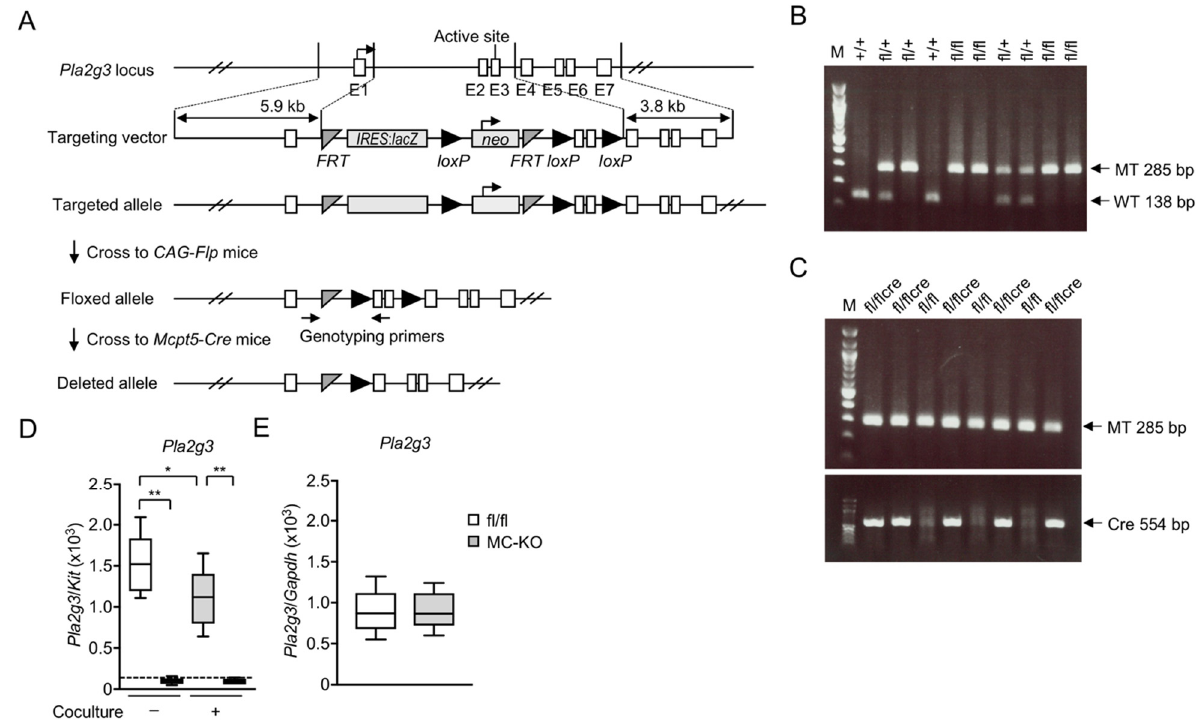
Figure 1. Generation of MC-specific Pla2g3 -deficient mice. ( A ) A schematic representation of the mouse Pla2g3 locus, the targeting vector from KOMP, the targeted Pla2g3 allele with a lacZ / neo cassette, the floxed Pla2g3 allele after removal of the lacZ cassette by flippase, and the Pla2g3 -deleted allele after removal of the neo cassette by Cre recombinase. The floxed mice were bred with Mcpt5 - Cre mice, and sequences between the two loxP sites were removed from the offspring’s genome in an MC-specific manner. Positions of primers for genotyping are marked with arrows. E1–7 (open boxes), Pla2g3 exons; FRT (gray isosceles triangles), sites for flippase; IRES , internal ribosome entry site; lacZ (gray box), gene encoding β -galactosidase; neo (gray box), neomycin phosphotransferase; loxP sites (black right triangles), target sites for Cre recombinase. Adapted from www.KOMP.org. ( B , C ) A representative genotyping PCR on agarose gels. The amplified PCR products specific for the floxed allele (MT, 285 bp), WT Pla2g3 allele (WT, 138 bp), and Mcpt5 - Cre allele (Cre, 554 bp) are indicated. ( D , E ) Quantitative RT-PCR of Pla2g3 in BMMCs with (+) or without ( − ) coculture with 3T3 fibroblasts (n = 6) ( D ) and splenocytes (n = 8) ( E ) from Pla2g3 fl/fl (fl/fl) and Pla2g3 fl/fl Mcpt-5 - Cre mice (MC-KO). The dotted line is the threshold for the detection limit. Data are presented as box plots with Tukey whiskers. *, p < 0.05; **, p < 0.01; one-way ANOVA ( D ); Mann–Whitney test ( E ). Data are pooled from 2 independent experiments, each of which gave similar results.